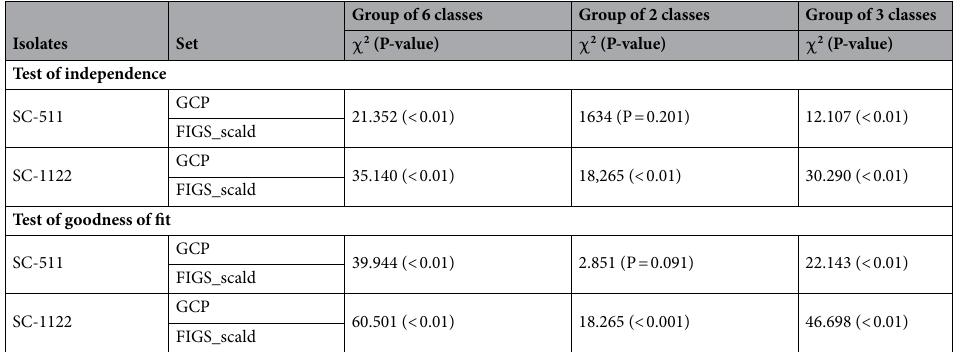
Table 2. χ 2 tests of independence and of goodness of fit of different groups of disease reaction classes to two scald isolates (511, 1122) under controlled conditions using GCP and FIGS subsets of barley. Group of 6-classes includes reaction types I, R, MR, MS, S, HS, group of 2-classes include I + R + MR and MS + S + HS, group of three classes include I + R, MR + MS, and S + HS. FIGS Focused Identification of Germplasm Strategy subset, GCP Generation Challenge Program reference set.